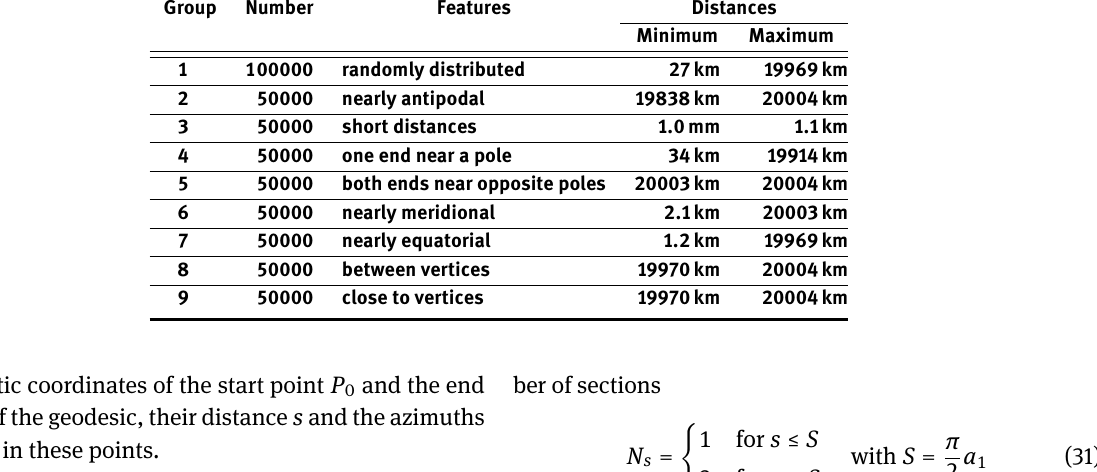
Table 1. Description of the data groups of the test data set.